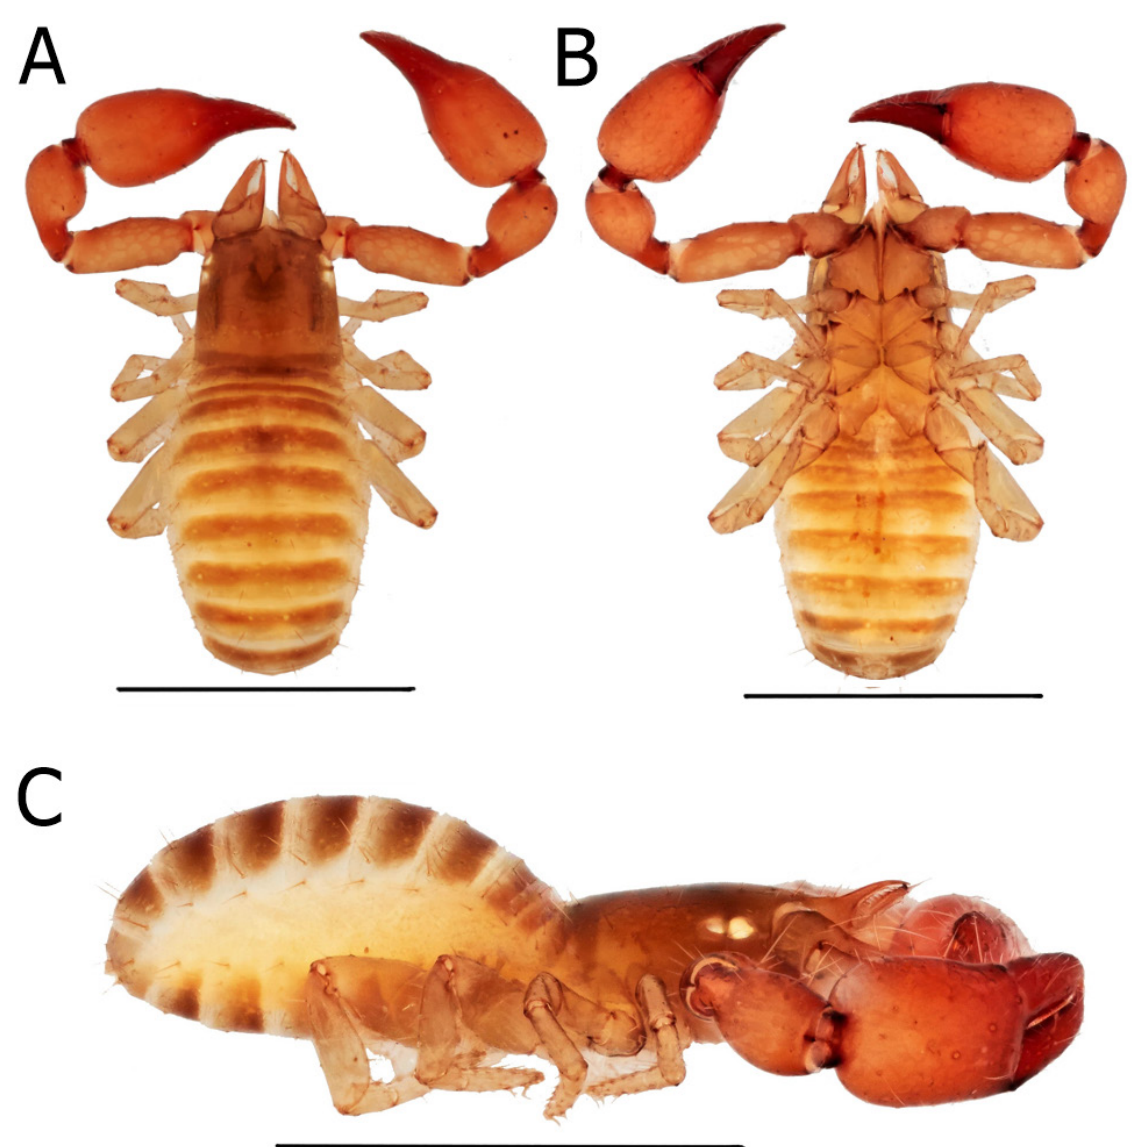
Fig. 14. Ideobisium susanae sp. nov., holotype, ♀ (QCAZ). A . Habitus in dorsal view. B . Habitus in ventral view. C . Habitus in lateral view. Scale bars = 1